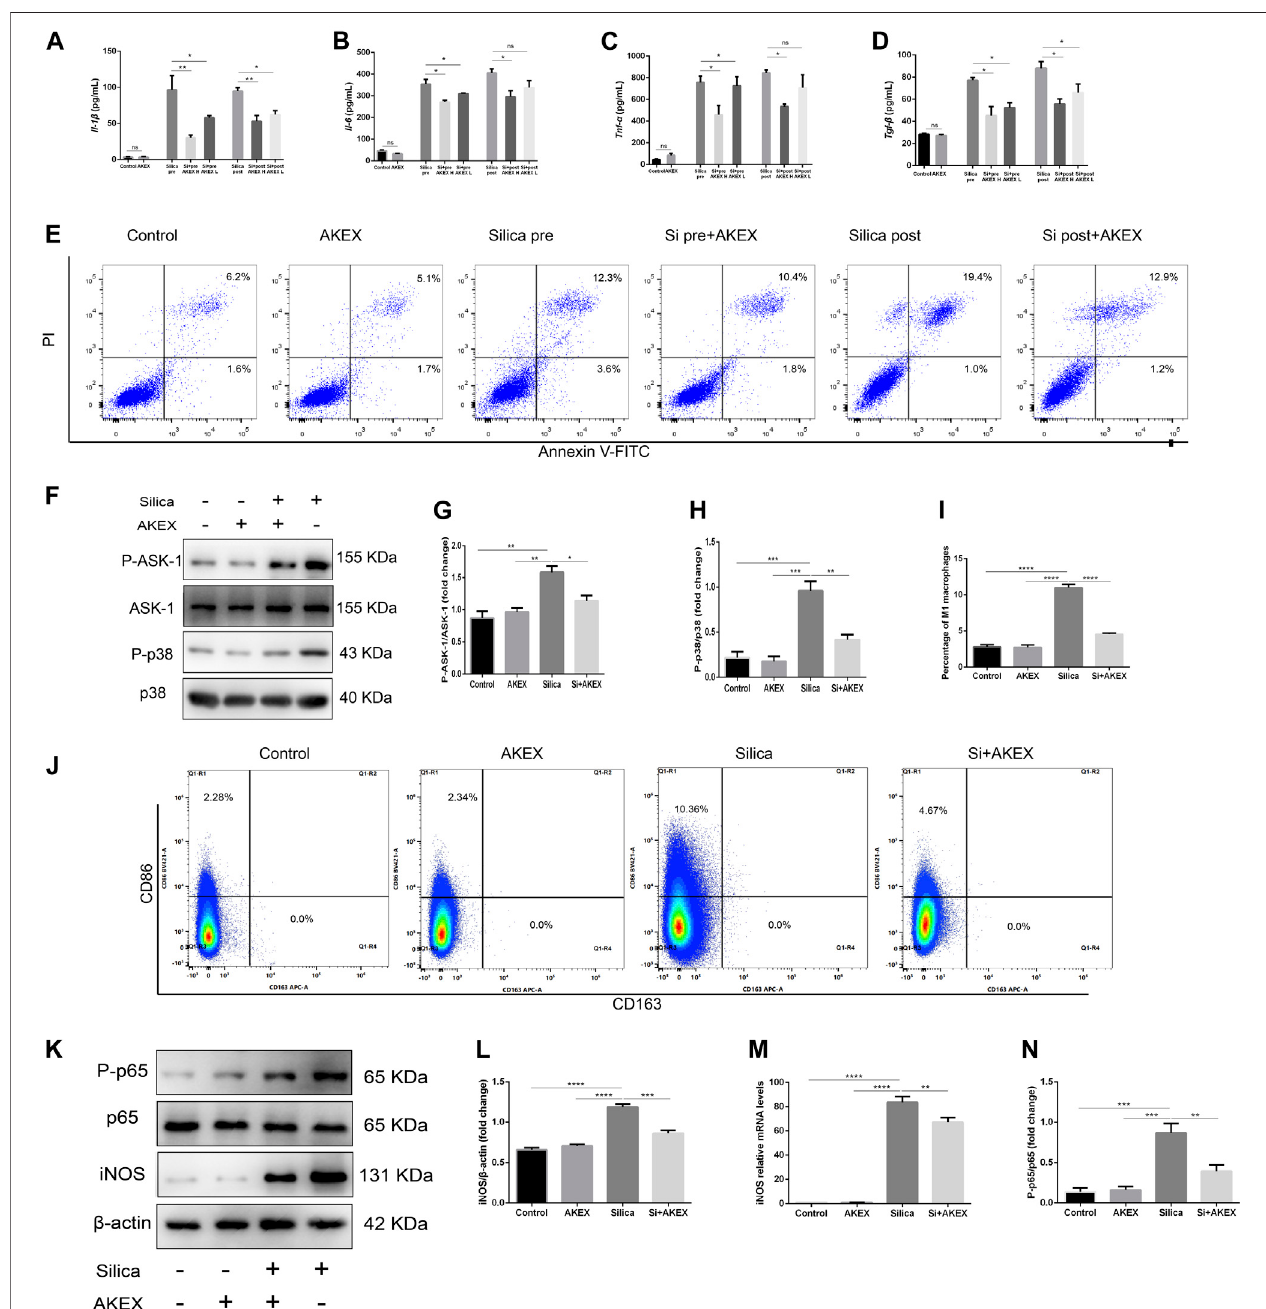
FIGURE 9 | AKEX0011 inhibited RAW264.7 from secreting pro-in fl ammatory cytokines, blocked p38 MAPK signaling, and reduced silica-induced apoptosis and M1 polarization. There were eight cell groups: PBS Control (abbreviated as “ Control ” in the graphs), PBS + AKEX0011 (200 μ g/ml) (abbreviated as “ AKEX ” ), Silica pre, Silicapre+AKEX0011(100 μ g/ml)(abbreviatedas “ Sipre+AKEXL ” ),andSilicapre+AKEX0011(200 μ g/ml)(abbreviatedas “ Sipre+AKEXH ” ),Silicapost,Silicapost+ AKEX0011(100 μ g/ml) (abbreviated as “ Sipost + AKEX L “ ), and Silica post + AKEX0011 (200 μ g/ml) (abbreviated as “ Si post + AKEX H ” ) (A – D) IL-6 IL-1 β , TNF- α , and TGF- β in cell supernatant detected by ELISA (n = 3). (E) Apoptosis (Annexin V+/PI – and Annexin V+/PI+) detection by FACS in each experimental group. (F – H) WB and quanti fi cation of P-p38, p38, P-ASK1, and ASK1. β -actin was used as a loading control. (I – J) M1 (F4/80 + CD86+) and M2 (F4/80 + CD163+) macrophage proportionsdetectedbyFACSinRAW264.7andstatisticalanalysis(n=3). (K) WBofiNOSP-p65p65. (L and N) Quanti fi cationofbanddensitiesfromWBimagesin(k), (n = 3). (M) mRNA levels of iNOS in lung tissues detected by qPCR (n = 3). All data were presented as mean ± SEM; * p < .05, ** p < .01, *** p < .001, and **** p < .0001.